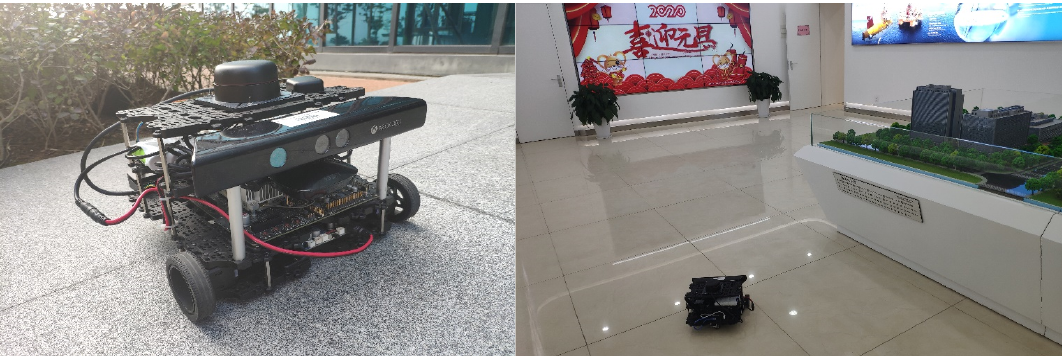
Figure 3. Simulation robot experiment